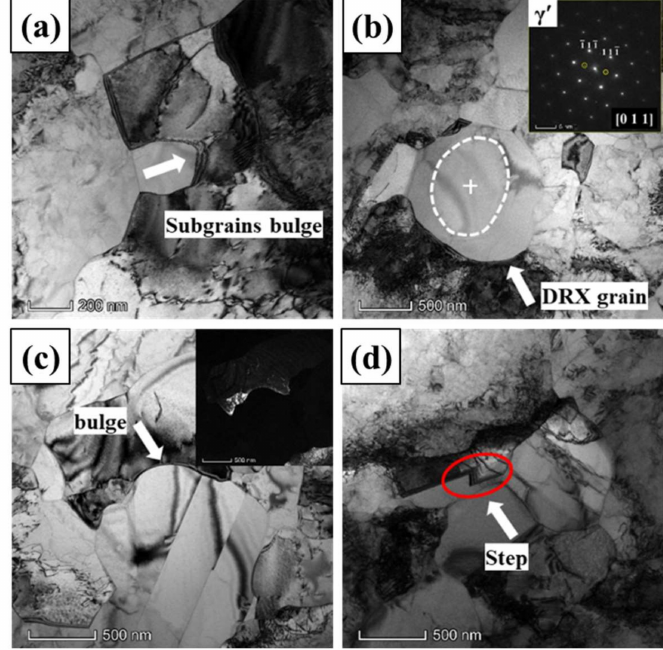
Figure 8. TEM images of GH4151 alloy after deformation at 1040 ◦ C, 0.1 s − 1 and strain of 0.3: ( a ) Subgrain bulge; ( b ) DRX grain; ( c ) Bulge; ( d ) Step-shaped grain